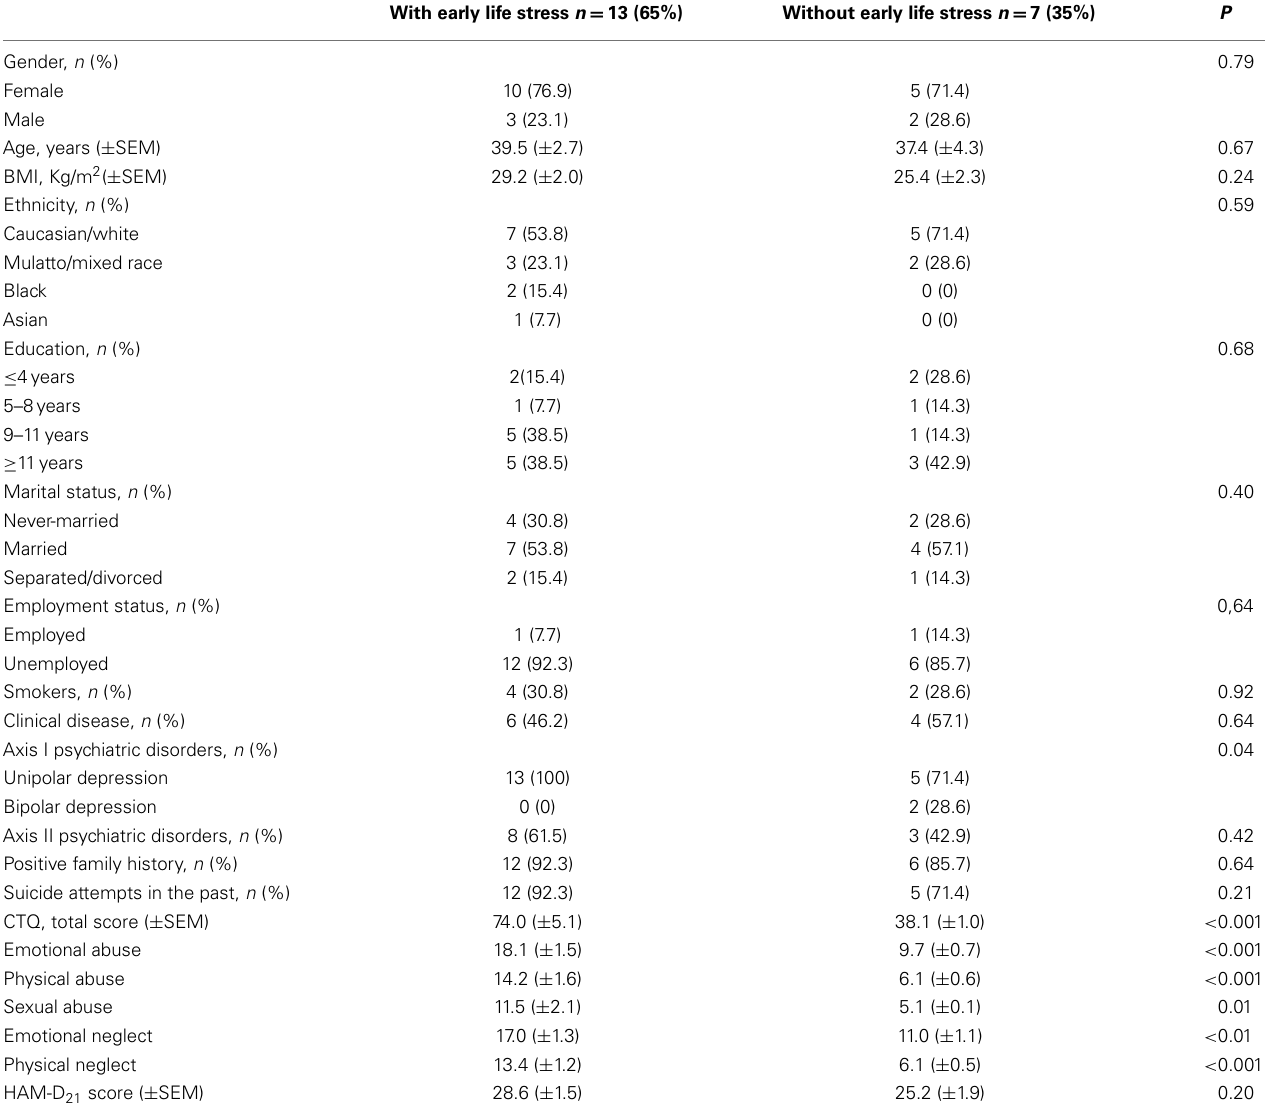
Table 1 | Demographic and clinical features of depressed patients with or without early life stress